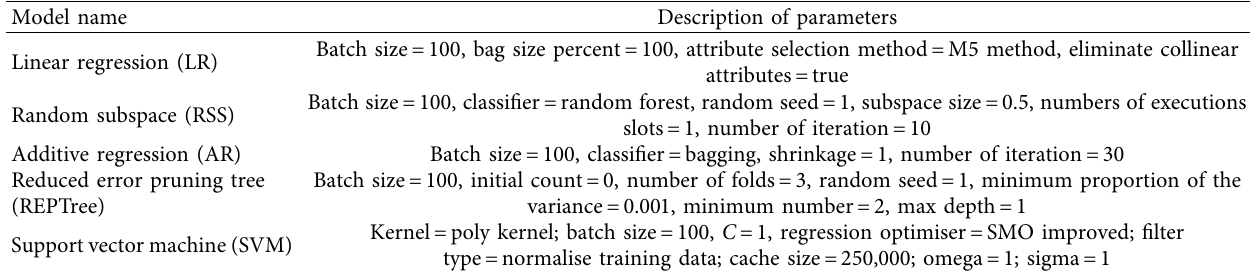
Table 2: The machine learning algorithm used in the study.